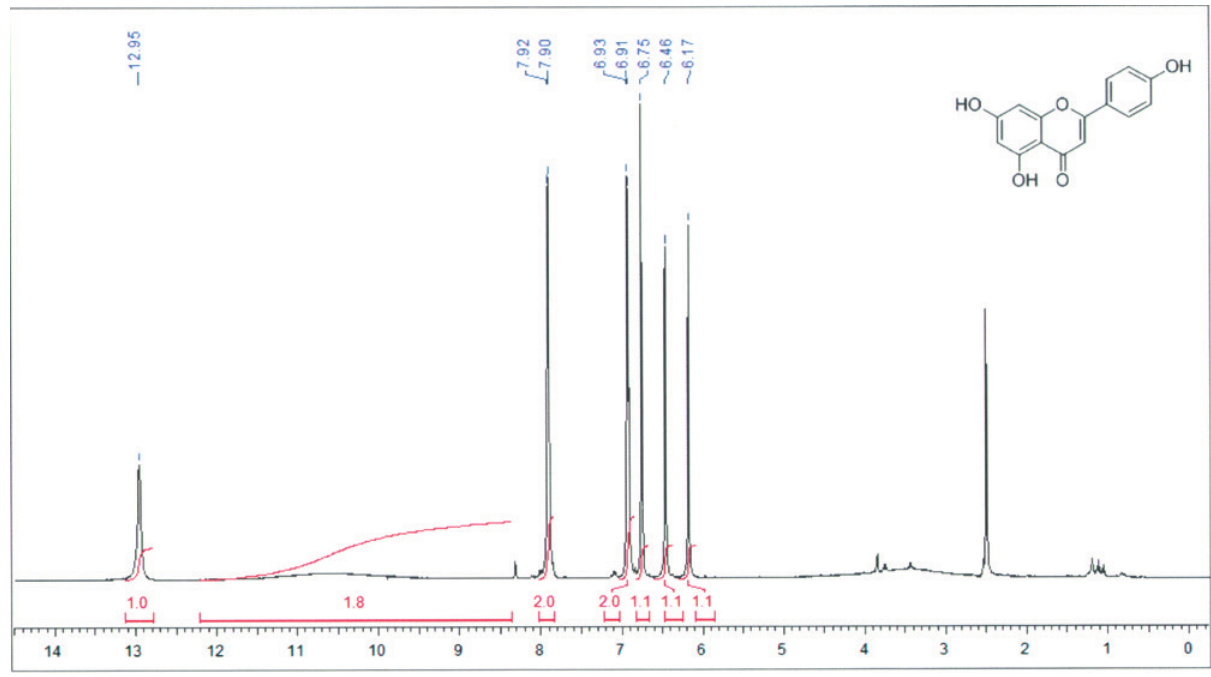
, 400 MHz) of synthesized 6